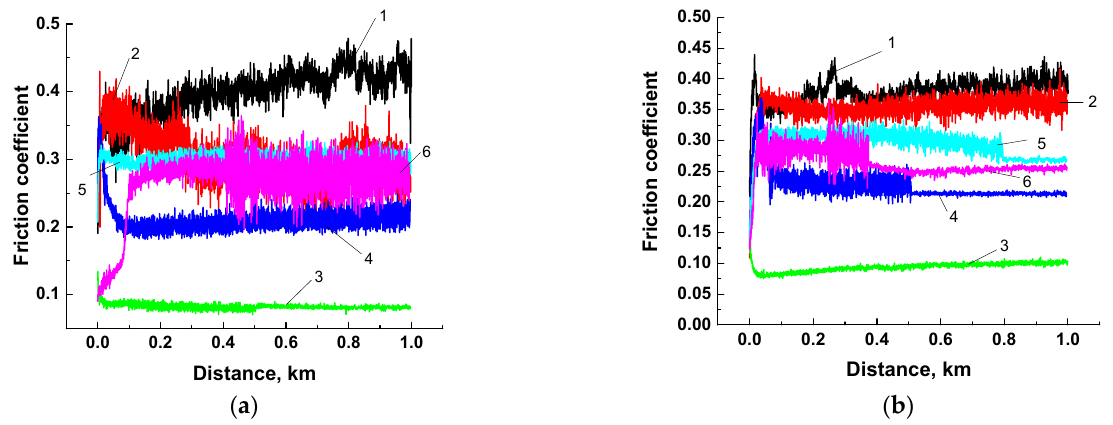
Figure 5. The friction coefficients for neat PI (1), as well as the PI/10CCF (2), PI/10CCF/10PTFE (3), PI/10CCF/10Gr (4), PI/10CCF/10MoS 2 (5), PI/10CCF/23MoS 2 (6) composites. Metal ( a ) and ceramic ( b ) counterparts. The ‘pin-on-disk’ scheme.